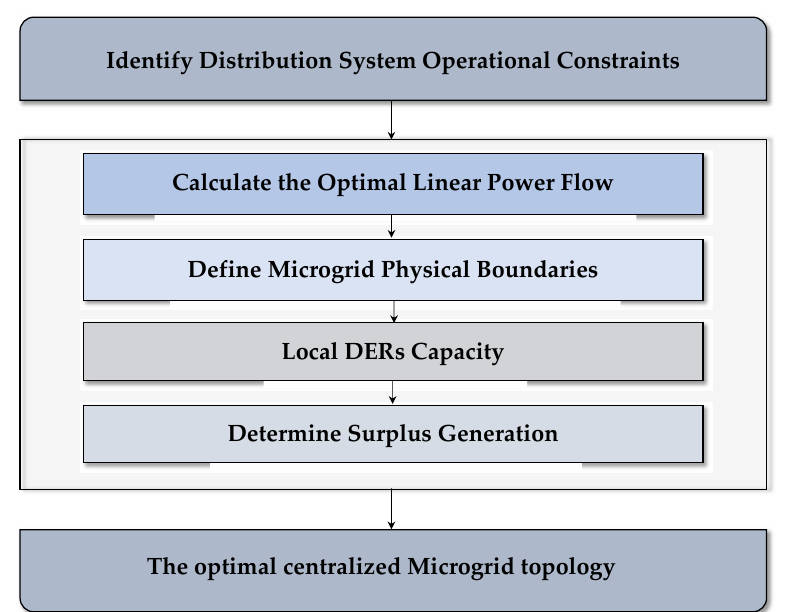
Figure 1. Flowchart of the proposed model.